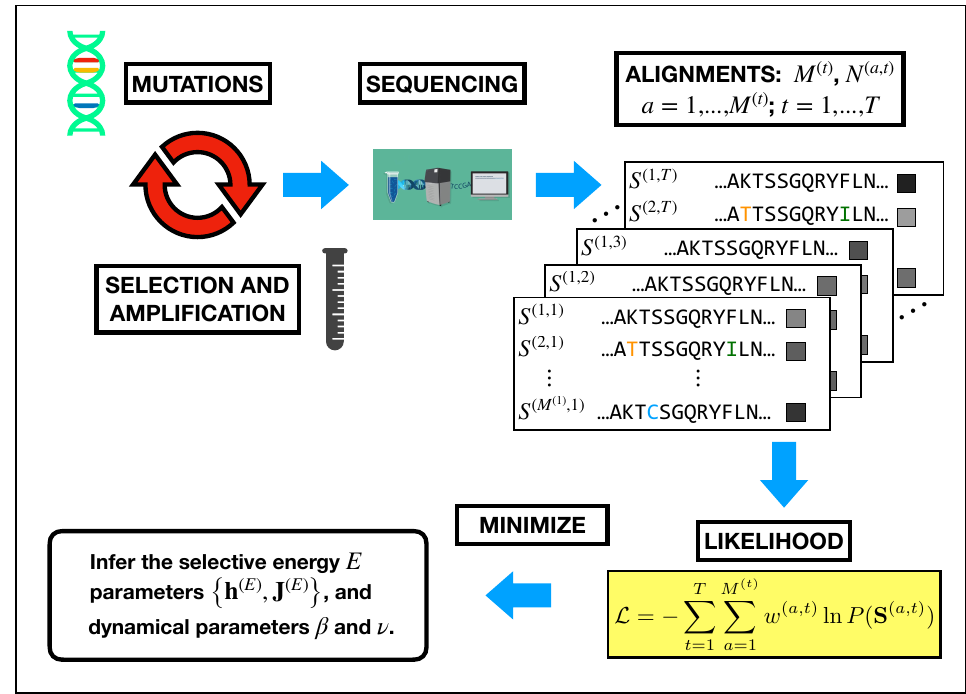
Figure 6. Pictorial representation of data generation in a Directed Evolution experiment and how they are plugged into the likelihood function to perform the inference. The sequencing of repeated rounds of mutation and selection generates a set of multiple sequence alignments. There, we highlighted with colored letters the sites that have been mutated with respect to the wild-type, coinciding with the first row of the alignment. Moreover, at the right of the sequences, boxes in gray-scale represents S ( t ) the abundances (increasing from black to white). Each sample of sequences and the related { } N ( t ) abundances for t = 1, . . . , T are used to define the likelihood function, which subsequently { } h ( E ) , J ( E ) , ν , β depends only on the parameters to be inferred: θ H = (see Equations (1)–(3) and (7)). { } The inference of these parameters is based on the maximization of the log-likelihood. In order to determine the parameters β and ν , the maximization problem over the energetic parameters is repeated, performing a scan over a set of possible values. Then the pair ( β opt , ν opt ) corresponding to the global maximum of the minus log-likelihood is